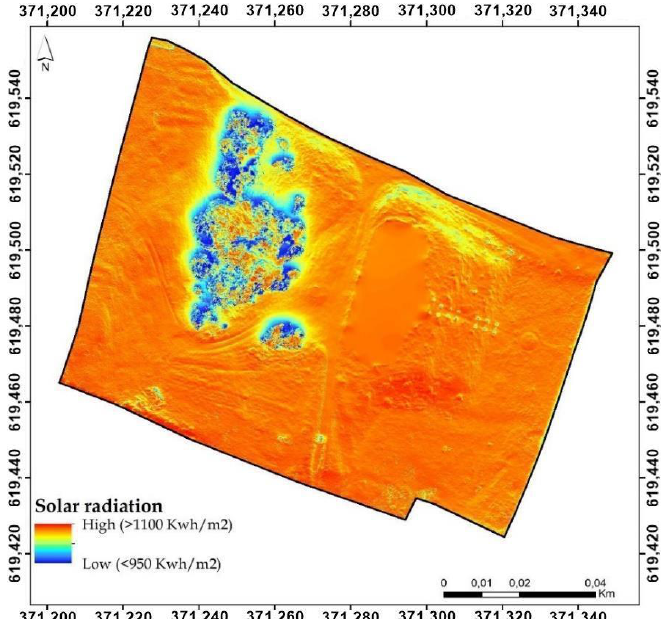
Figure 17. Solar radiation illustration.